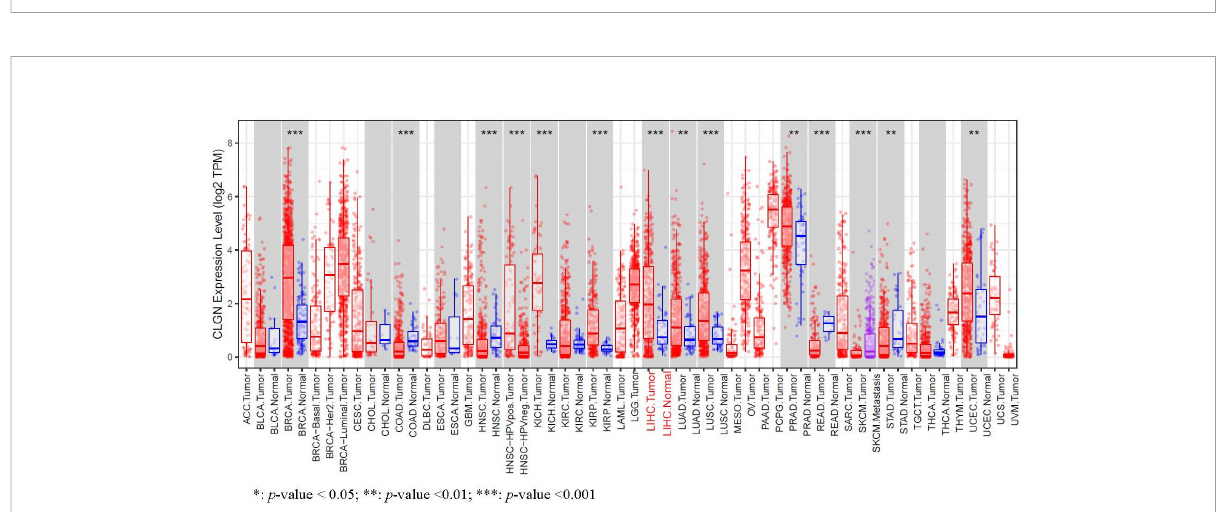
FIGURE 3 The mRNA expression of levels of CLGN in several common human tumors. The mRNA of CLGN was upregulated in liver and other tumors